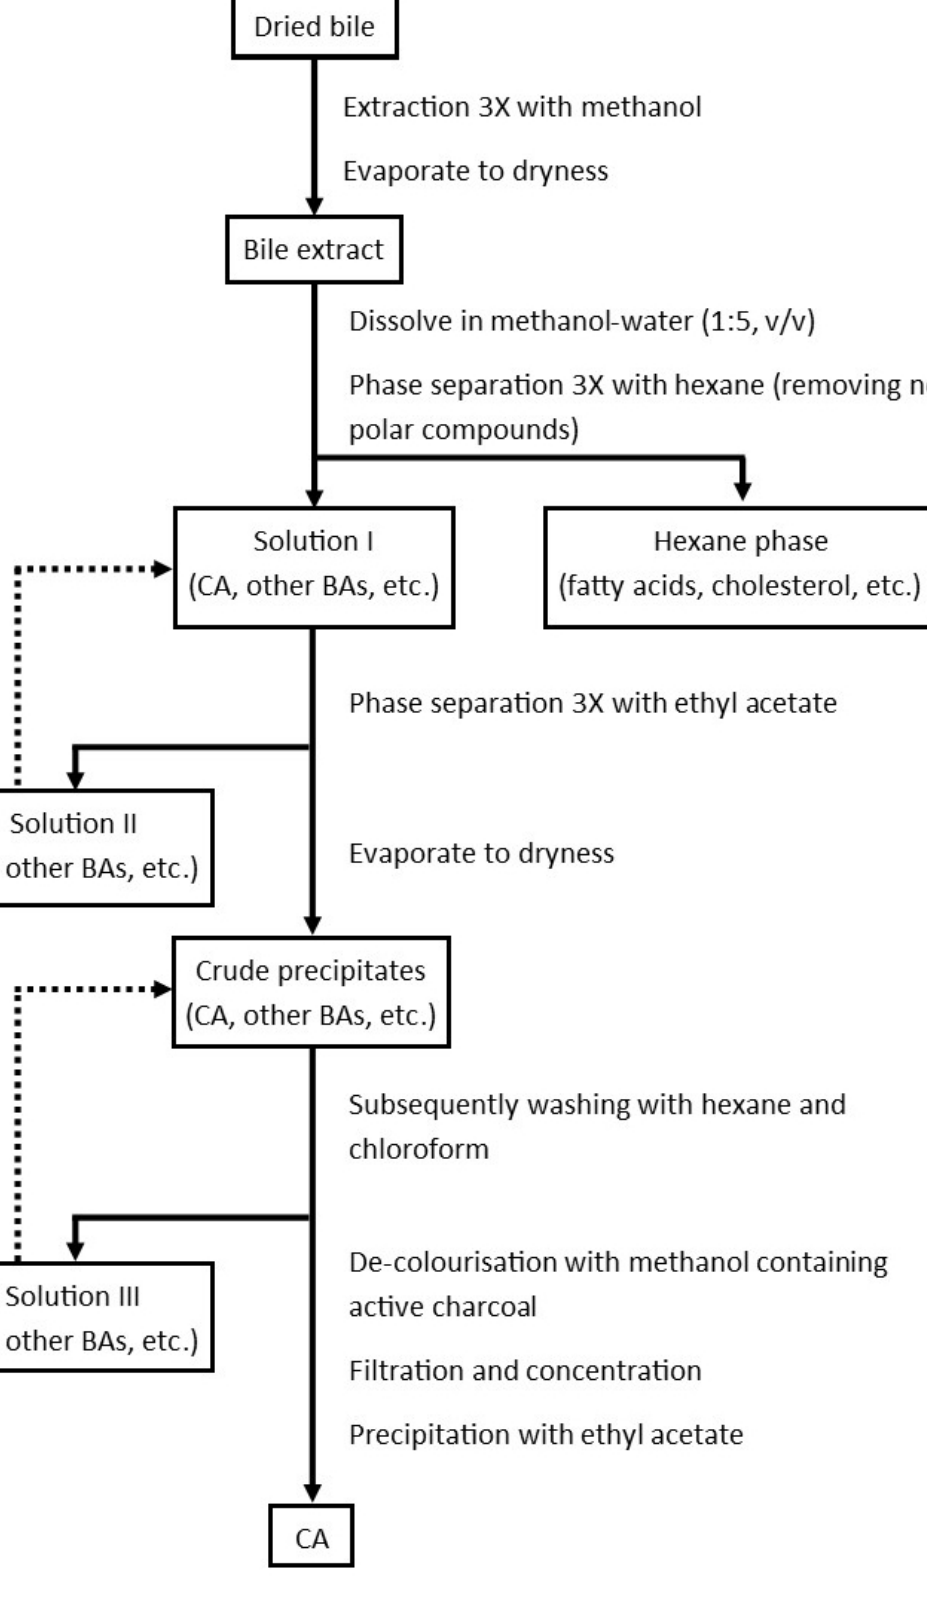
FIGURE 7 - Purification steps of CA from tilapia